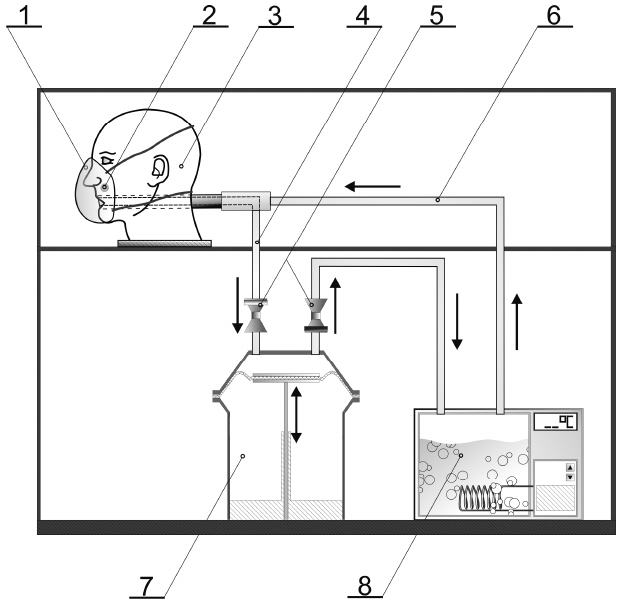
Figure 1. The scheme of the test stand used to simulate breathing cycles while wearing an FFR (1—FFR, 2—integrated temperature and humidity data logger, 3—Sheffield dummy head, 4—inhalation line, 5—valves, 6—exhalation line, 7—breathing machine, 8—saturator).